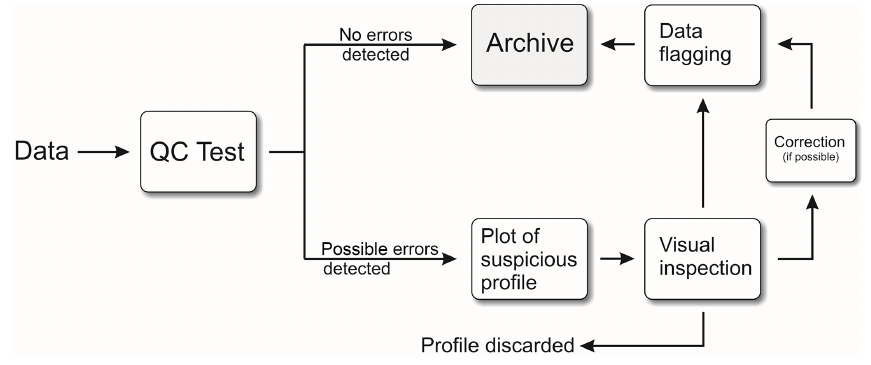
Figure 2. Working principle of the data-quality